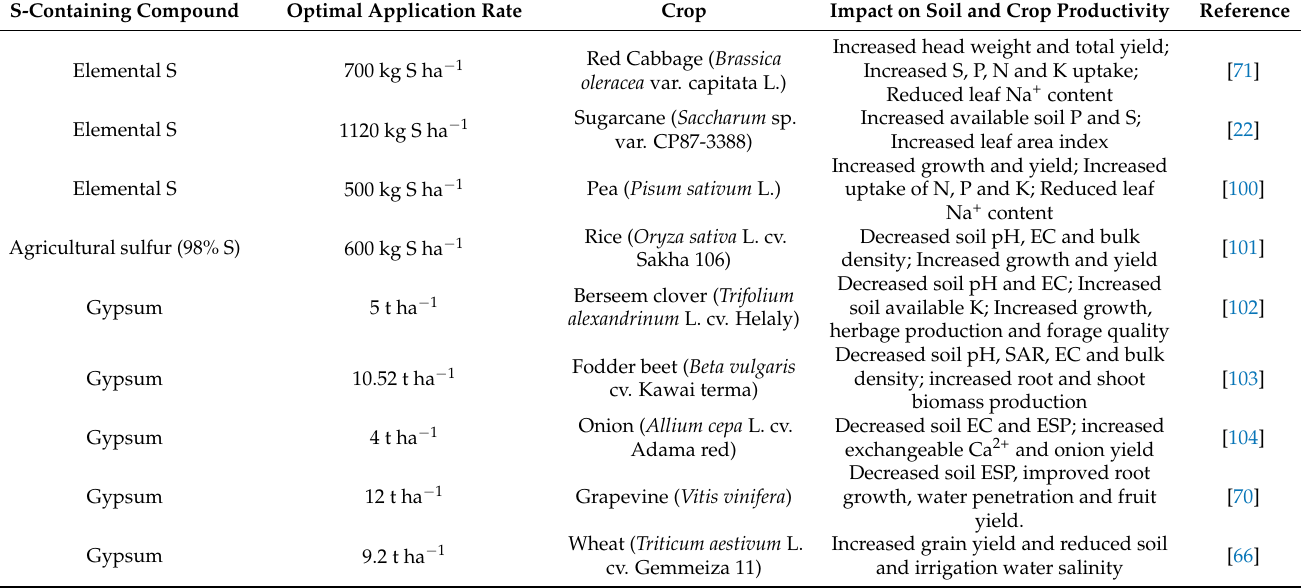
Table 1. The effects and rates of S-containing compounds in the amelioration of salinity stress on crops. S-Containing